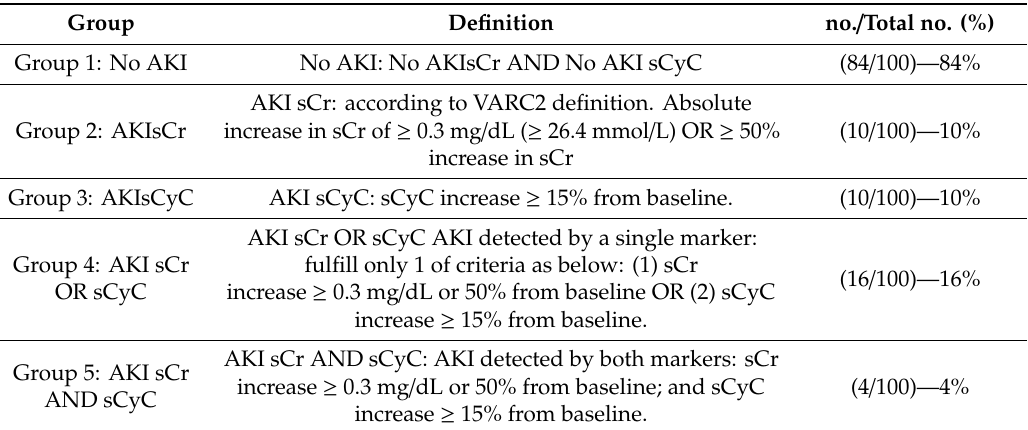
Table 4. Acute Kidney injury (AKI) definitions and